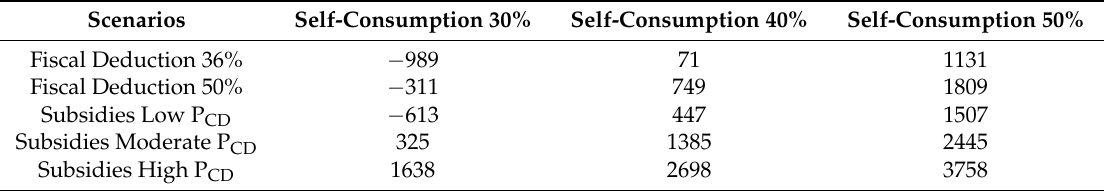
Table 6. NPV in alternative scenario (p s = 4 cent € /kWh). Data expressed in € .